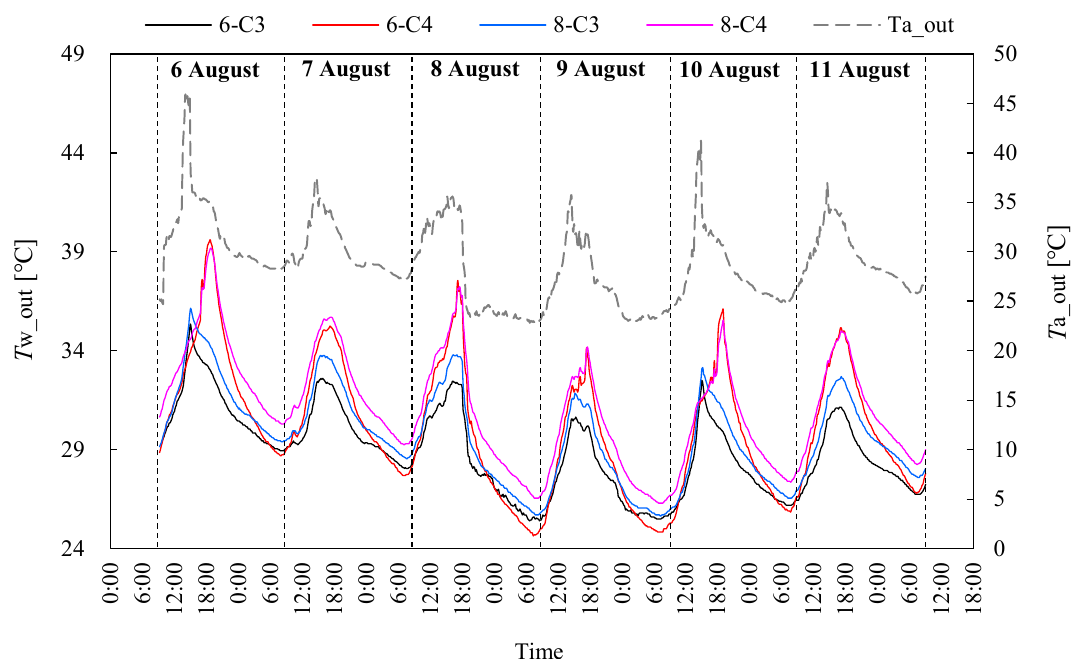
Figure 6. Outer wall surface temperature ( T w_out) and outdoor air temperature ( T a_out) of rooms 6-C3, 6-C4, 8-C3, and 8-C4.